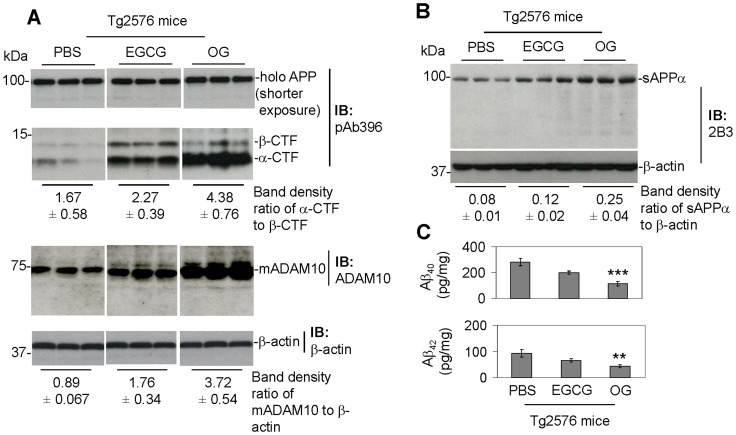
Tg2576 mice treated with OG showed markedly increased α-secretase cleavage of APP and significantly decreased levels of Aβ generation.A total of 13 Tg2576 female mice were used in this study over a period of one week. Five mice received OG or EGCG, and the remaining three received PBS. Beginning at 6 months of age (adult), Tg2576 mice were intracerebroventricular (i.c.v.) injected with OG or EGCG (10 µg in 5 µl PBS; this dose was suggested by our preliminary rangefinder study) or PBS (5 µl) daily through the implanted cannulae. Mice were sacrificed 24 h after the last injection for analysis of sAPPα, CTFs of APP, Aβs, and ADAM10 activation in brain homogenates using IB analyses and ELISA. IB analysis results show (A, top) holo APP and two bands corresponding to β-CTF and α-CTF by an APP-carboxyl-terminal antibody (pAb396), (A, bottom) mature ADAM10 (mADAM10) by an anti-carboxyl-terminal ADAM10 antibody (ADAM10) and (B) sAPPα production by a specific sAPPα antibody (2B3). As shown below each IB, densitometry analysis shows the band density ratios (mean ± SD) of α-CTF to β-CTF, mature ADAM10 (mADAM10) to β-actin and sAPPα to β-actin. (C) Detergent-soluble Aβs were analyzed by ELISA. Data are represented as mean ± SD of Aβ (pg/mg protein). For (C), a t test revealed a significant difference between OG- and EGCG-treated or PBS-injected Tg2576 mice for soluble total Aβ (Mean ± SD; **P<0.005; ***P<0.001). Most notably, OG-treated Tg2576 mice show much higher levels of APP processing into sAPPα and α-CTF as well as mADAM10 compared with either PBS- or EGCG-treated mice.